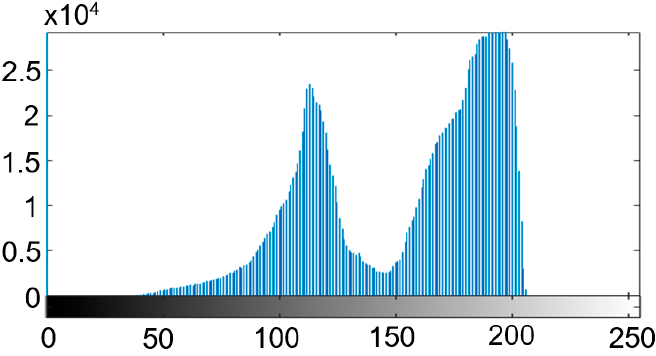
Figure 7. Gray histogram of Comprehensive image after gray weighted average.